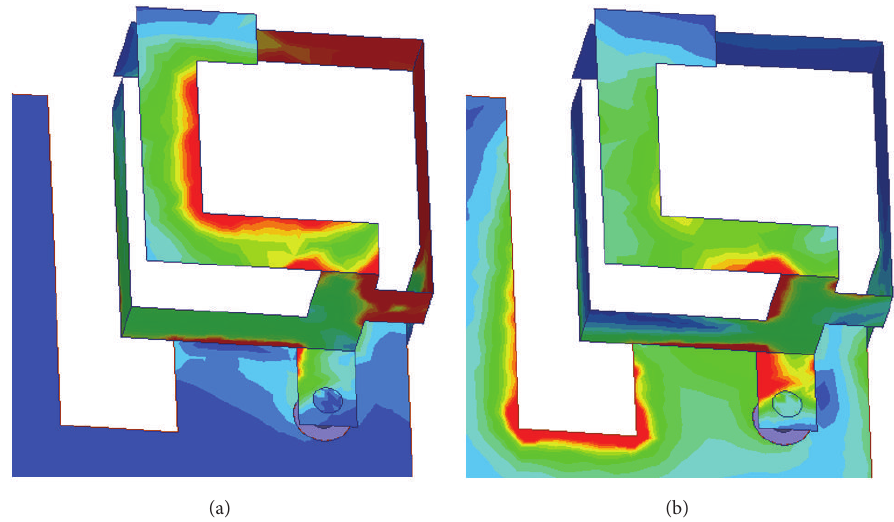
Figure 6: Simulated surface current distributions of the antenna element. (a) At 1.9 GHz; (b) at 2.35 GHz.